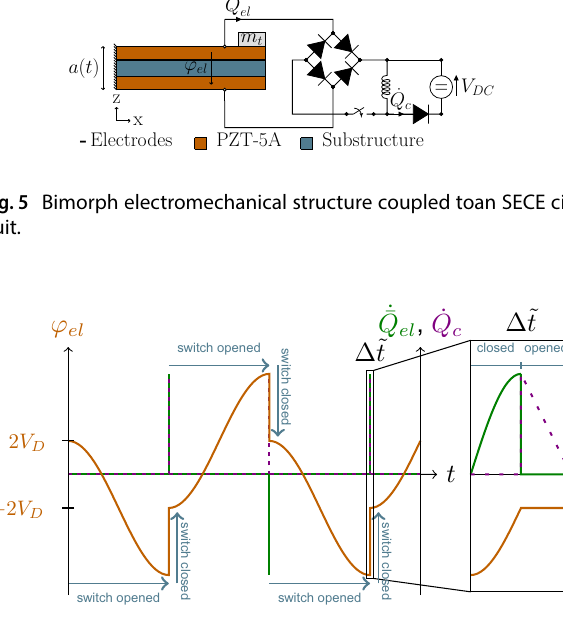
Fig. 6 Typical waveforms of 𝜑 el , ̇̄ Q el and ̇̄ Q c arising from the SECE circuit under a harmonic base excitation of the electromechanical